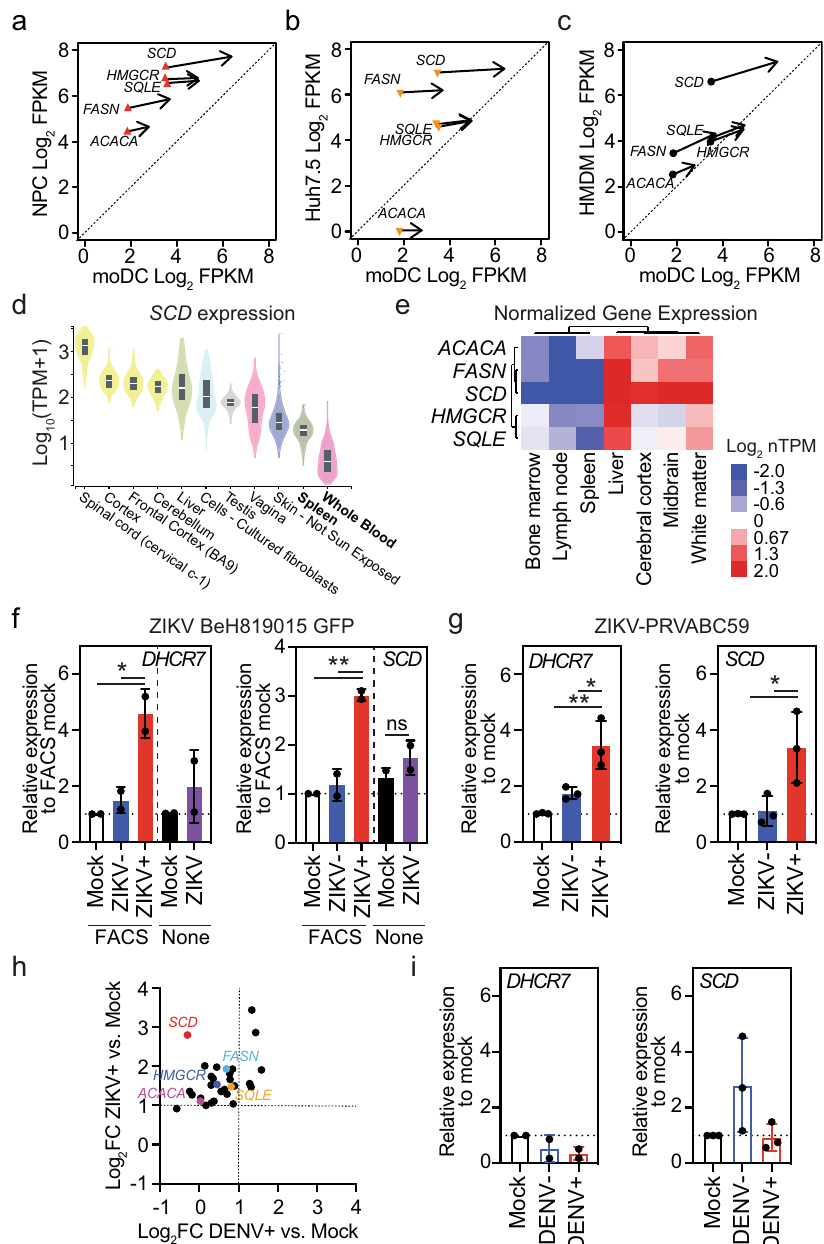
Fig. 2 | Cell type- and virus-speci fi c reprogramming oflipid metabolismgenes. a – c Effect of ZIKV infection on the expression of rate-limiting enzymes in choles- terol and fatty acid synthesis in a neural progenitor cells (NPCs), b Huh7.5 human hepatomacells,and c humanmonocyte-derivedmacrophages(HMDMs)compared with moDCs. Eachsymbol represents the baseline expressionand the arrows point totheexpressioninZIKV+cells. d SCD expressionintissuesthatcanbeinfectedby ZIKVinorderofmedianexpressionlevel(datafromGTExAnalysisReleaseV8).The boxshowsthemedianvalueandextendsfromthe25thto75thpercentile,whilethe whiskersextendfrommintomaxvalues.Pointsaredisplayedasoutliersiftheyare above or below 1.5 times the interquartile range. e Unsupervised clustering of normalized expression (Log 2 nTPM) of the indicated genes in the indicated tissues (data from The Human Protein Atlas v21.0) 22 . f , g qRT-PCR analysis of the relative